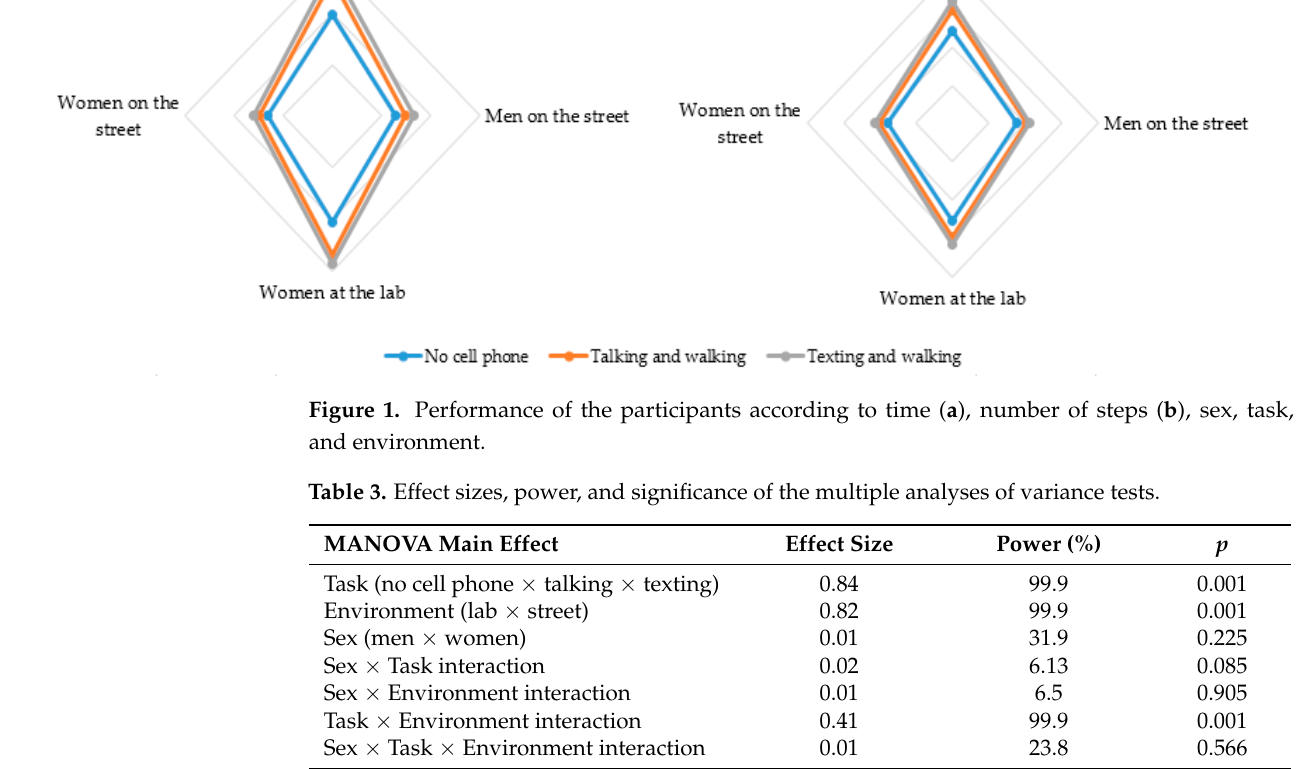
Table 3. Effect sizes, power, and significance of the multiple analyses of variance tests.